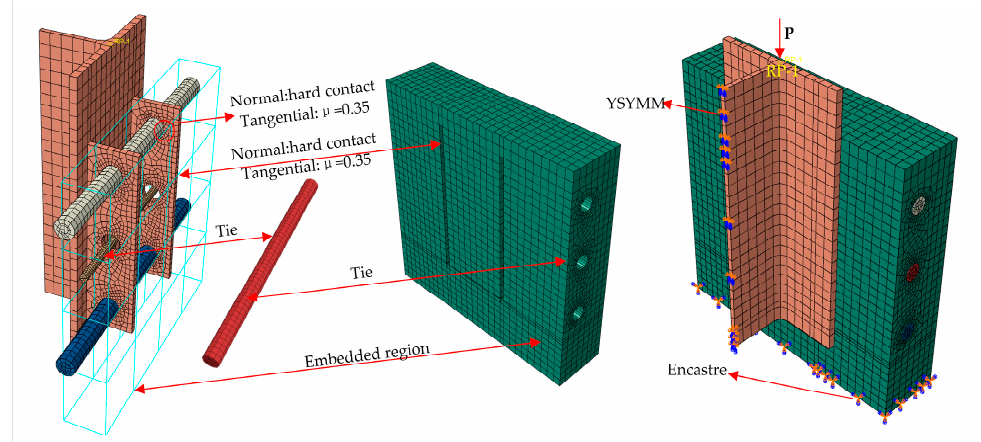
Figure 12. FE model.